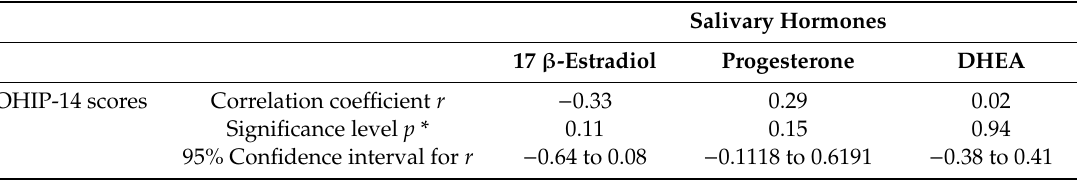
Table 4. Correlation between self-perceived quality of life questionnaire (OHIP-14) scores and salivary hormones.